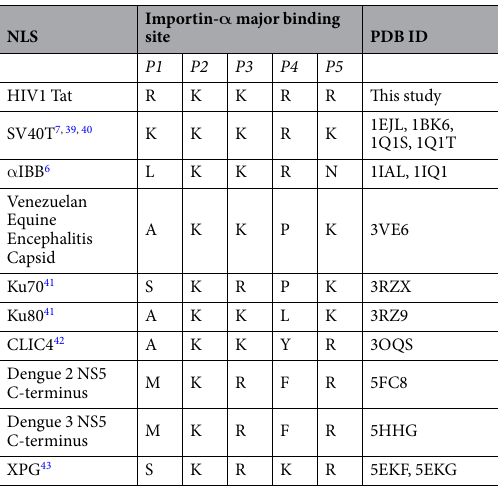
Table 3. PDB deposited cNLSs binding to the major site of importin- α